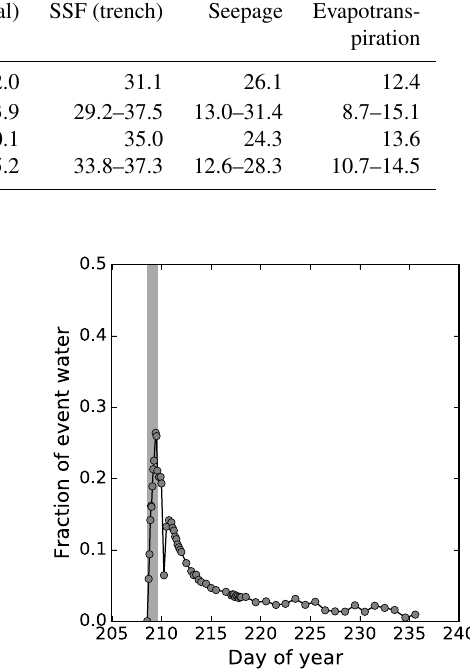
Figure 6. Fraction of event water captured at the trench during the sprinkler experiment based on a two-component mixing model. The gray area represents application period of labeled irrigation